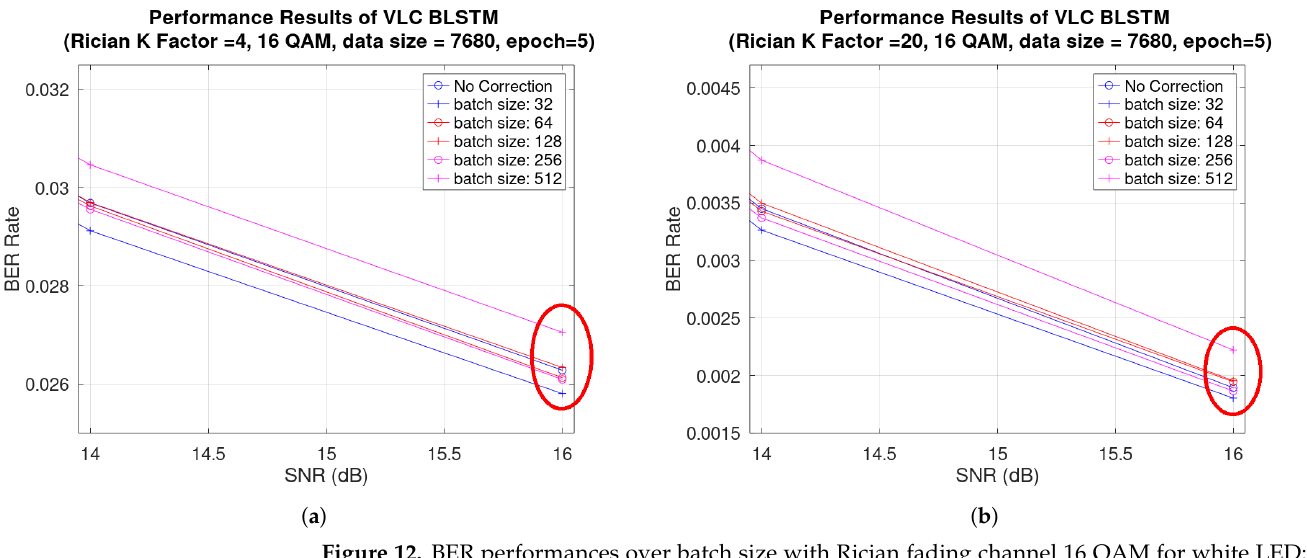
Figure 12. BER performances over batch size with Rician fading channel 16 QAM for white LED: ( a ) K Factor = 4; ( b ) K Factor = 20.